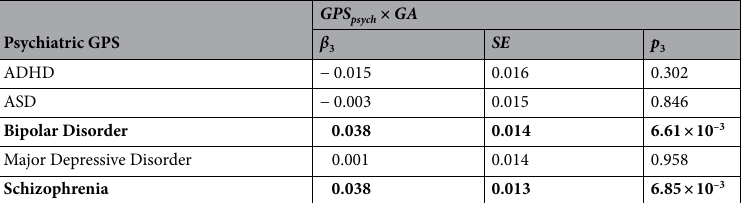
Table 1. Gene-environment interaction between genetic risk for psychiatric disease and gestational age at birth on cognition at four. Results exploring the effect of the interaction term GPS psych × GA on cognitive outcome in 4934 unrelated individuals. β 3 is the estimate of the effect size of the interaction term GPS psych × GA , SE is the standard error of the effect size and p 3 is the corresponding p-value. Bonferroni correction was used to adjust for multiple testing and p-values < 0.01 (0.05/5) were considered statistically significant. Significant results are indicated in bold. Beta regression coefficients and associated p-values for all terms in the regression model are detailed in Supplementary Table S3 in the Supplementary